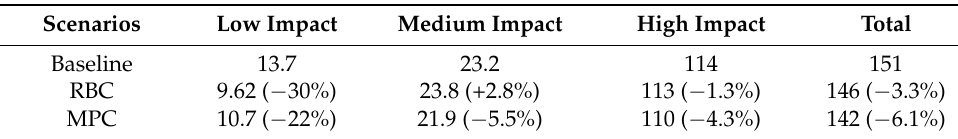
Table 3. Simulated environmental impact risk point (EIRP) values expressed as millions for different environmental impact areas and their relative reduction.